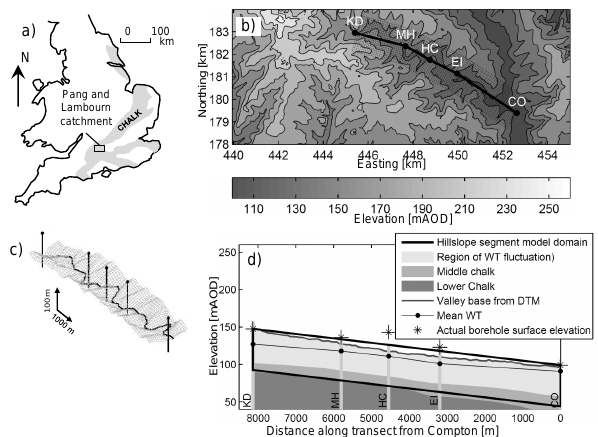
Fig. 1. The hillslope transect: (a) site location; (b) regional topog- raphy; (c) topography of transect within winding valley; (d) cross- sectional profile of transect, showing model domain, observation wells and major hydrogeologic stratigraphy. The following obser- vation wells are labelled: Knollend Down (KD), Malthouse (MH), Hodcott (HC), East Ilsley (EI) and Compton